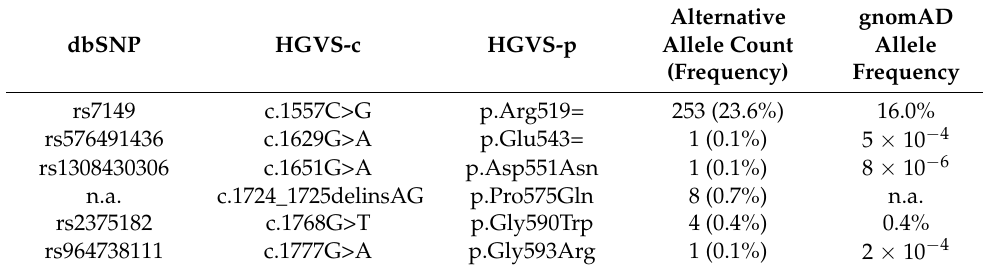
Table 1. Details of the six detected UNC93B1